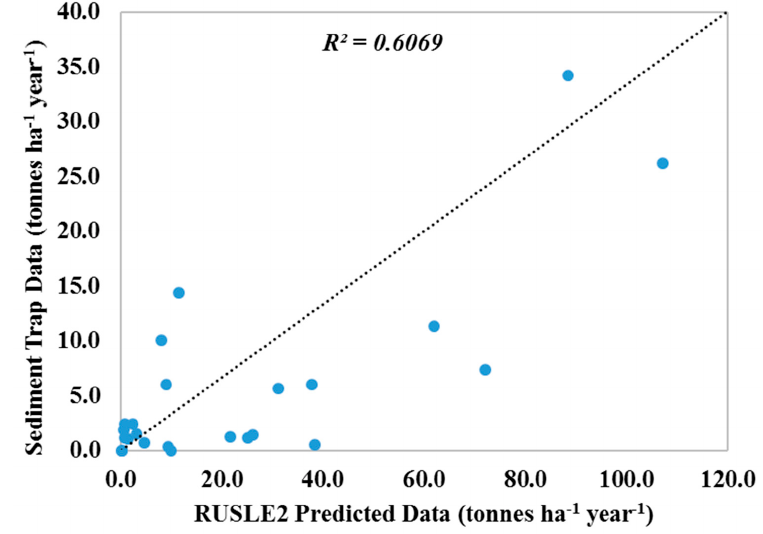
Figure 6. Linear relationship of RUSLE2 modeled data and actual measured erosion data. Line on graph represents a 1:1 relationship.